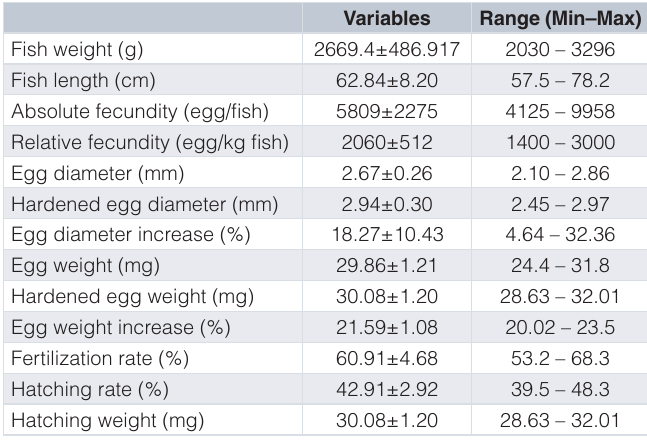
Table 1. Female size, egg characteristics and hatchery performance of Hemibagrus wyckii (Mean ± SD).